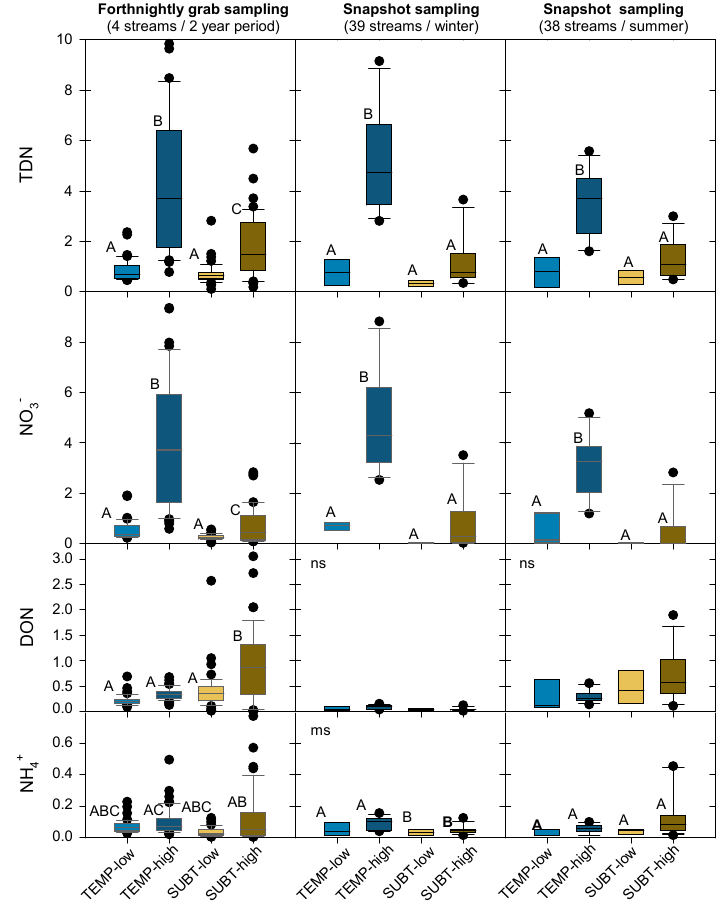
Figure 4. The concentration of dissolved nitrogen fractions in fortnightly grab sampling in benchmark streams and snapshot samples. Significance level P < 0.05. A, B, and C describe statistical groups according to post hoc Bonferroni tests. We indicate non-significant results as ns (p > 0.1), and marginally significant as ms (0.05 < P < 0.1). Abbreviations: TEMP: temperate streams; SUBT: subtropical streams; low- and high-FI: low and high-farming intensity. Vertical axes are concentrations expressed in mg N · L − 1 . The upper and lower boundaries of the box mark the 25th and 75th percentile, whiskers above and below the box indicate the 90th and 10th percentiles and the line within the box marks the median. Black dots display outliers. Note that the scale varies among fractions.